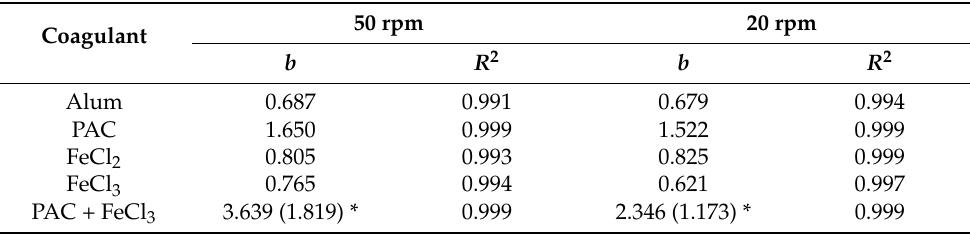
Figure 1. The residual [PO 4 -P] profiles and model predictions according to the coagulant type. Agitation speed of ( a ) 50 rpm or ( b ) 20 rpm was applied for the slow mixing (17 h 50 min) after the initial rapid mixing (150 rpm) of 10 min. Table 3. The exponential decay constants ( b ) and the coefficients of determination ( R 2 ) derived from the sensitivity test.